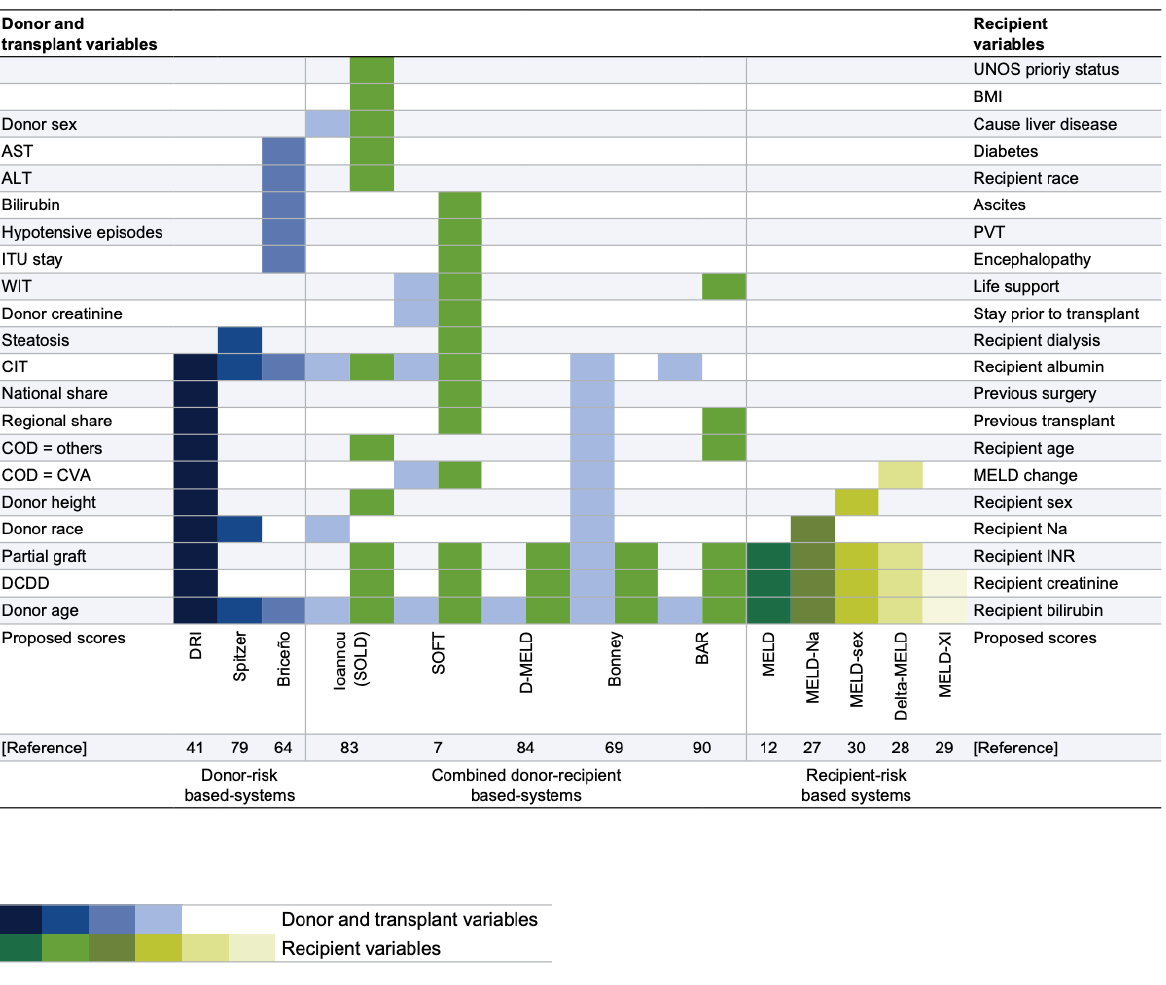
Figure 1. Different D – R matching systems based on donor and recipient variables. COD, cause of death; CVA, cardiovascular accident; DCDD, donation after circulatory determination of death; PVT, portal vein thrombosis. Figure obtained from Briceno J, Ciria R, de la Mata M. Donor – recipient